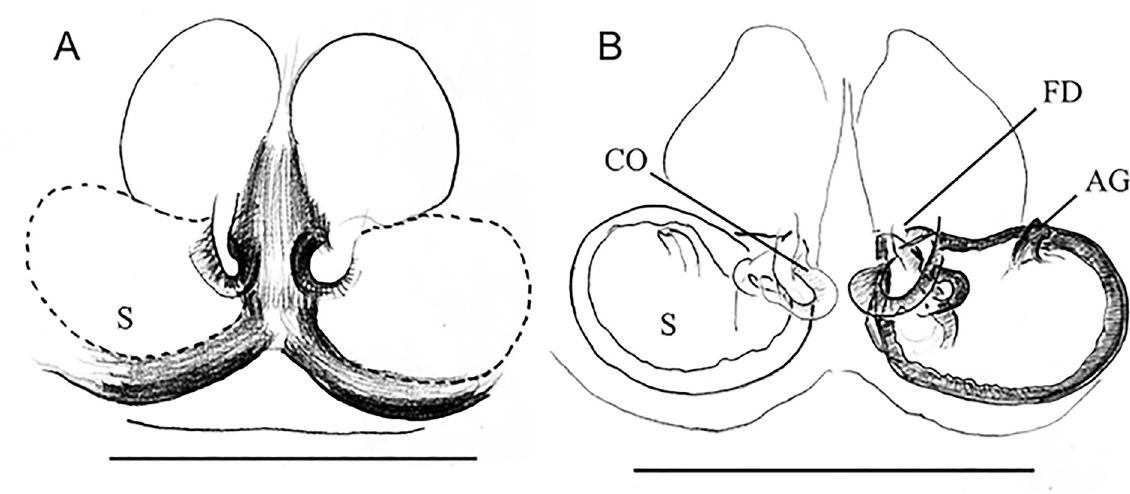
Fig 4. Carrhotus albosetosus sp. nov. A . Epigynum, ventral view. B . Vulva, dorsal view. Abbreviations: AG = accessory gland; CO = copulatory opening; FD = fertilization duct; S = spermatheca. Scale bars = 0.1 mm.